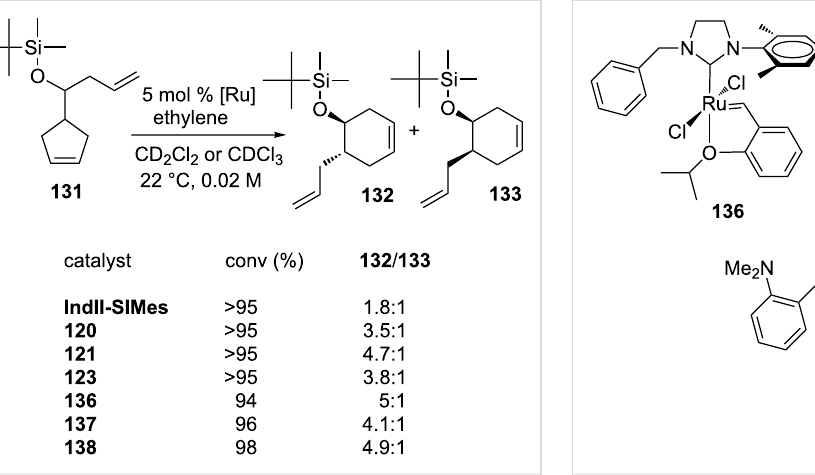
Scheme 12: Diastereoselective ring-rearrangement metathesis (dRRM) of cyclopentene 131 .